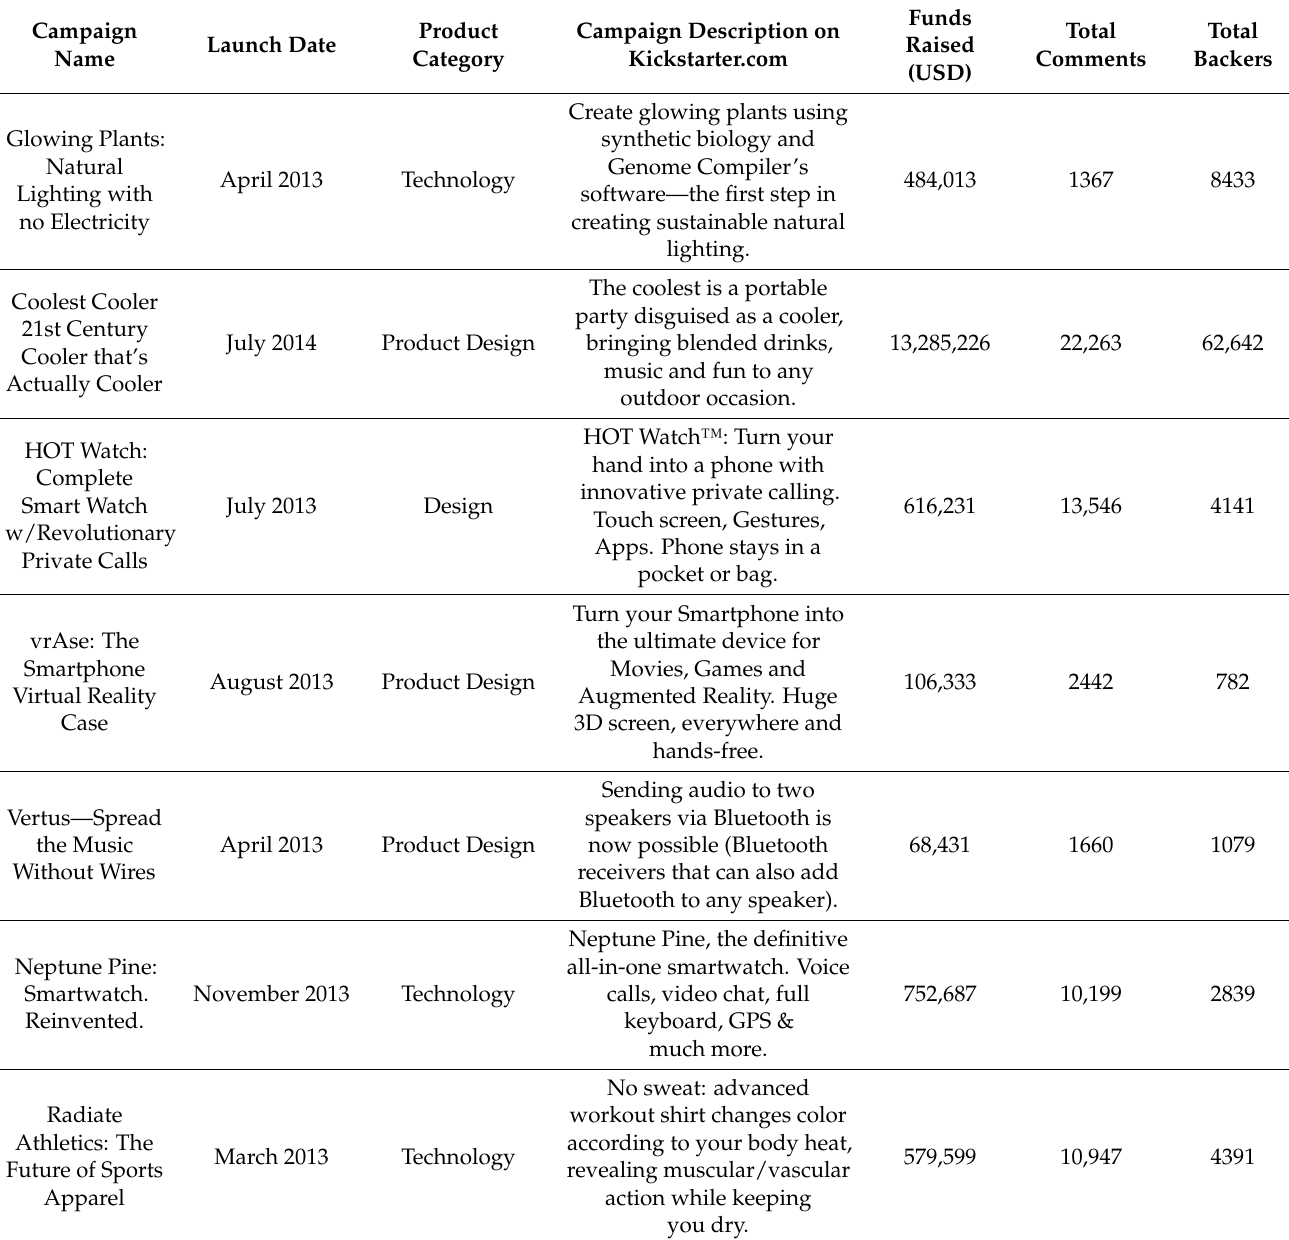
Table 2. Overview of Selected Kickstarter